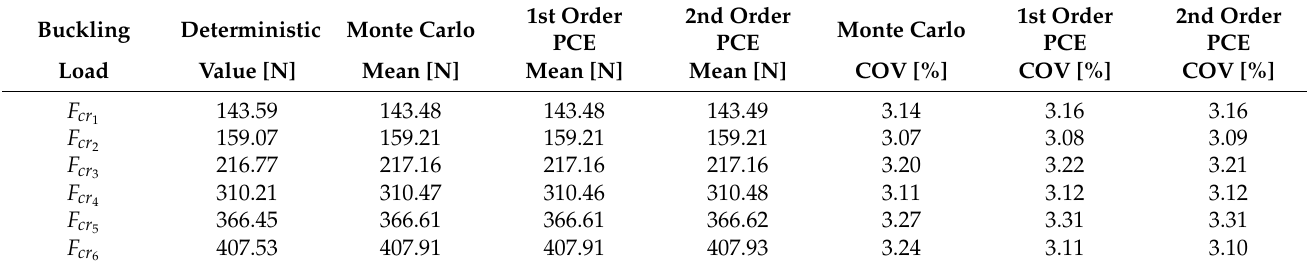
Table 6. Case 1 critical buckling loads mean value and standard deviation calculated by means of pure Monte Carlo and first- and second-order